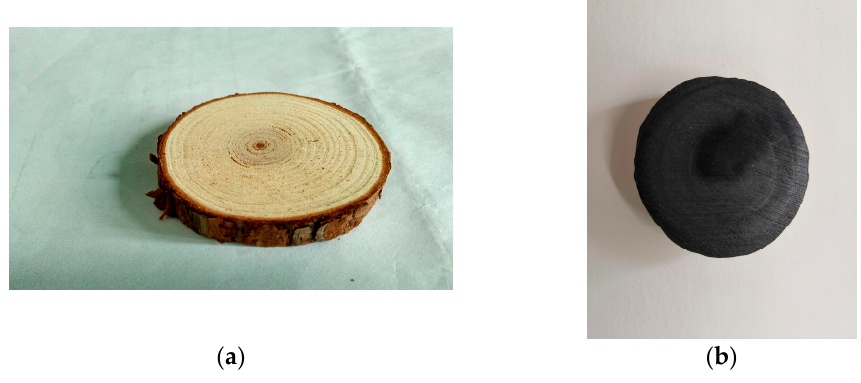
Figure 4. ( a ) Wood material before treatment. ( b ) Wood material after treatment.